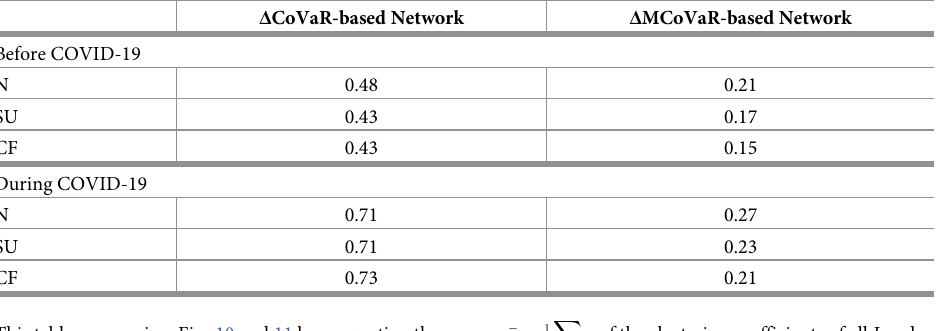
Table 10. Averaged node clustering coefficients of conditional tail risk